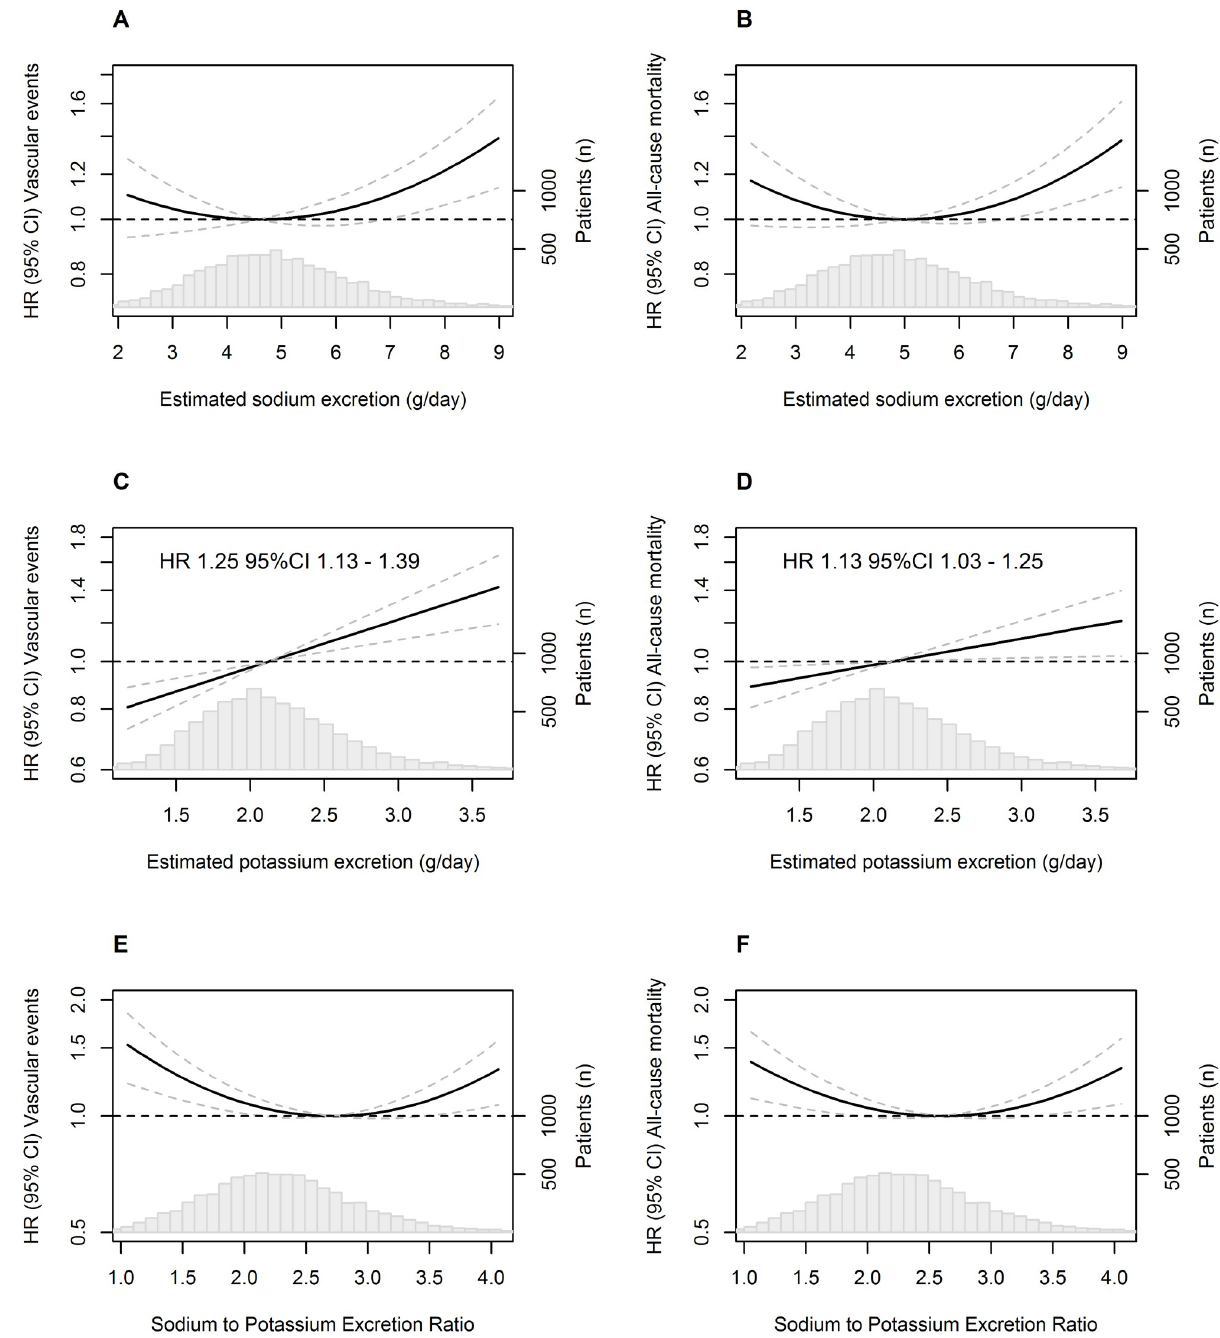
Fig 1. Relation between salt excretion and recurrent cardiovascular events and mortality. Adjusted hazard ratios for vascular events and mortality by baseline estimated salt excretion (distribution shown by histogram) A. Relation between estimated 24-hour urinary sodium excretion and vascular events (linear term P = 0.02; non-linear term P < 0.01). Nadir: 4.59 g/day. B. Relation between estimated 24-hour urinary sodium excretion and mortality (linear term P < 0.01; non-linear term < 0.01). Nadir: 4.97 g/day. C. Relation between 1 gram/day higher estimated 24-hour urinary potassium excretion and vascular events. D. Relation between 1 gram/day higher estimated 24-hour urinary potassium excretion and mortality. E. Relation between sodium-to-potassium excretion ratio and vascular events (linear term P < 0.01; non-linear term < 0.01). Nadir: 2.71 g/day. F. Relation between sodium-to-potassium excretion ratio and mortality (linear term P < 0.01; non-linear term < 0.01). Nadir: 2.60 g/day. All hazard ratios were plotted between the 1 st and 99 th percentile of the corresponding salt measure. Dotted lines represent 95% confidence intervals. All models were adjusted for age, sex, current smoking, BMI (kg/m 2 ), presence of diabetes, eGFR, and non-high-density lipoprotein cholesterol. HR = Hazard ratio.